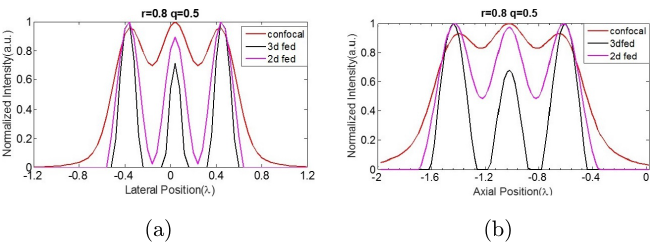
Fig. 3. Linear pro¯le of normalized intensities. (a) Linear pro¯le of simulation results along lateral direction. (b) Linear pro¯le of simulation results along axial